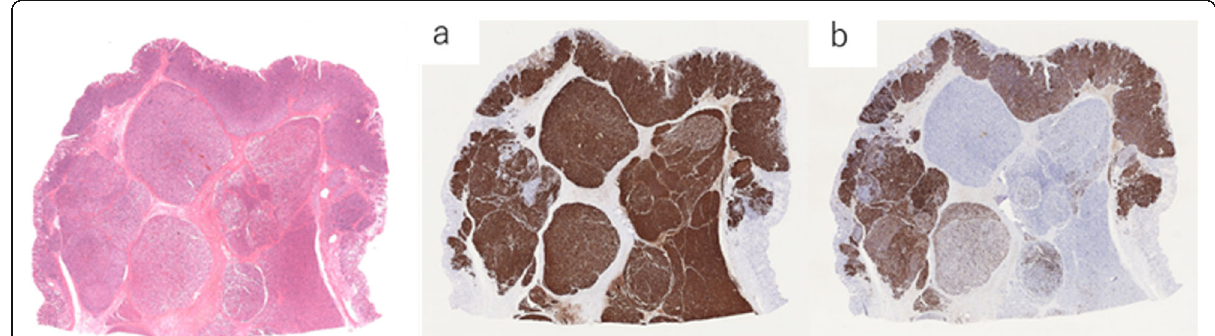
Fig. 6 ( a , b ) a : anti-BCL-10 antibody staining b : chromogranin A